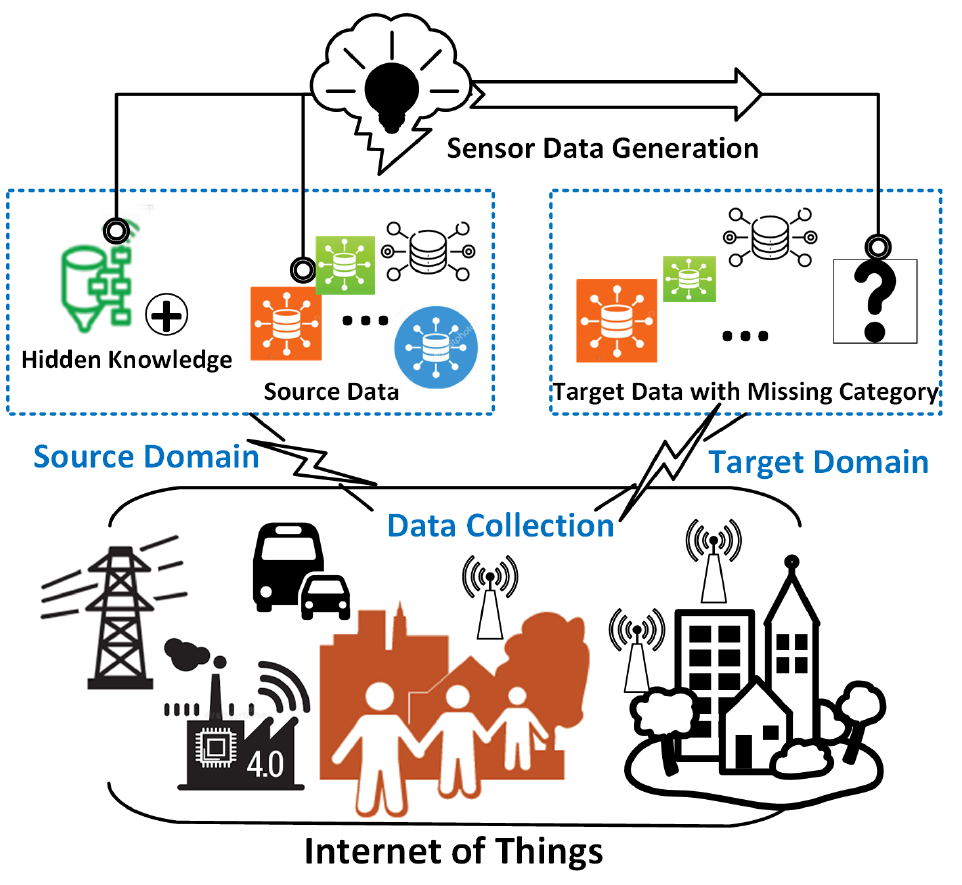
Figure 1. An illustration of challenges for cross-domain sensor data generation. Various data from different domains can be collected from the sensor networks deployed in the smart buildings and Internet of Networks. To generate missing data categories in the target domain, we need to solve two challenges: (1), How to Capture the hidden knowledge in the source domain? (2), How to generate data within the target